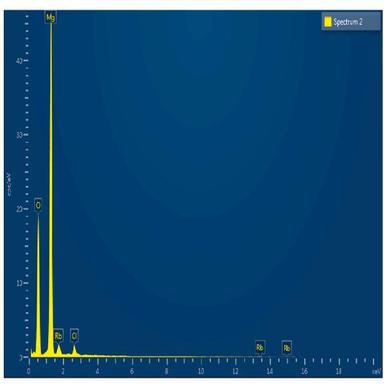
EDAX spectrum of RbCl doped MgO nanoparticles.